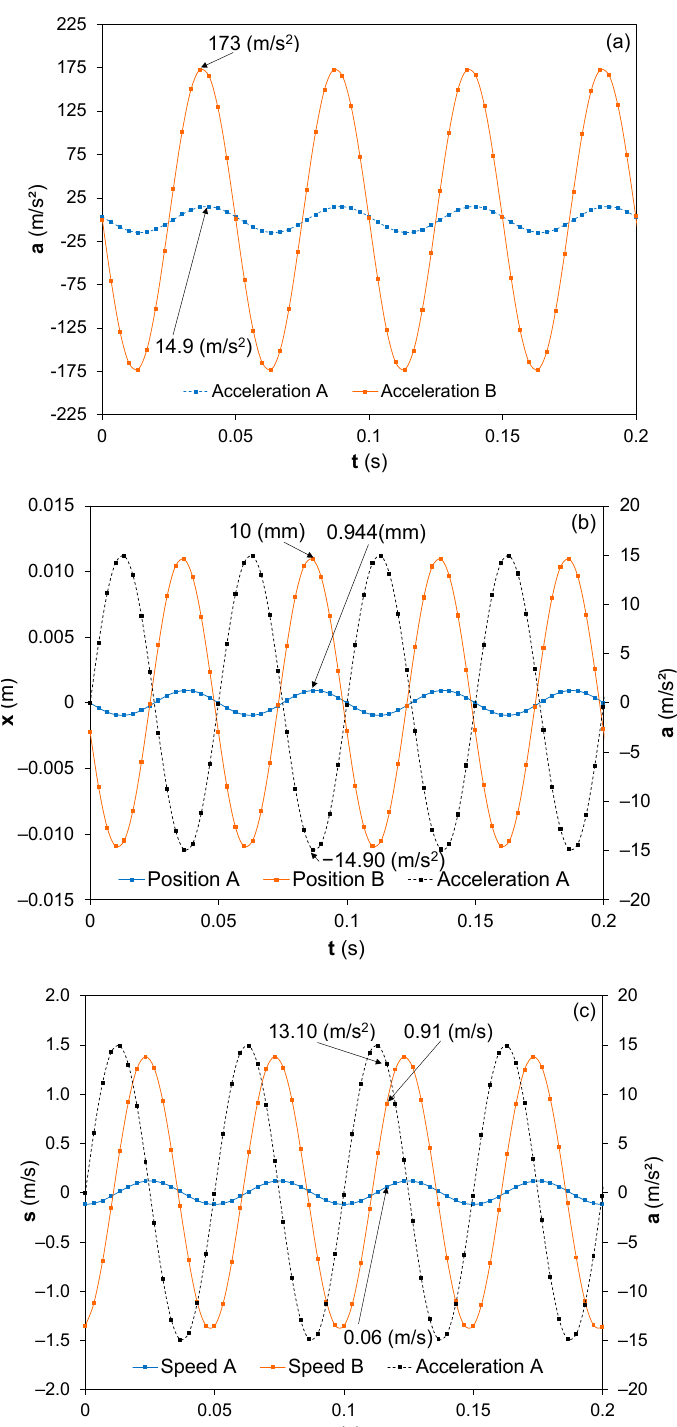
Figure 5. Experimental results of the piezoelectric bimorph cantilever at f = 20 Hz and excitation acceleration of ± 15 m/s 2 . ( a ) The acceleration measurements at the free and the fixed ends of the beam, ( b ) the displacement obtained at both ends, and ( c ) the speed of the free end and the speed and the acceleration of the fixed end.